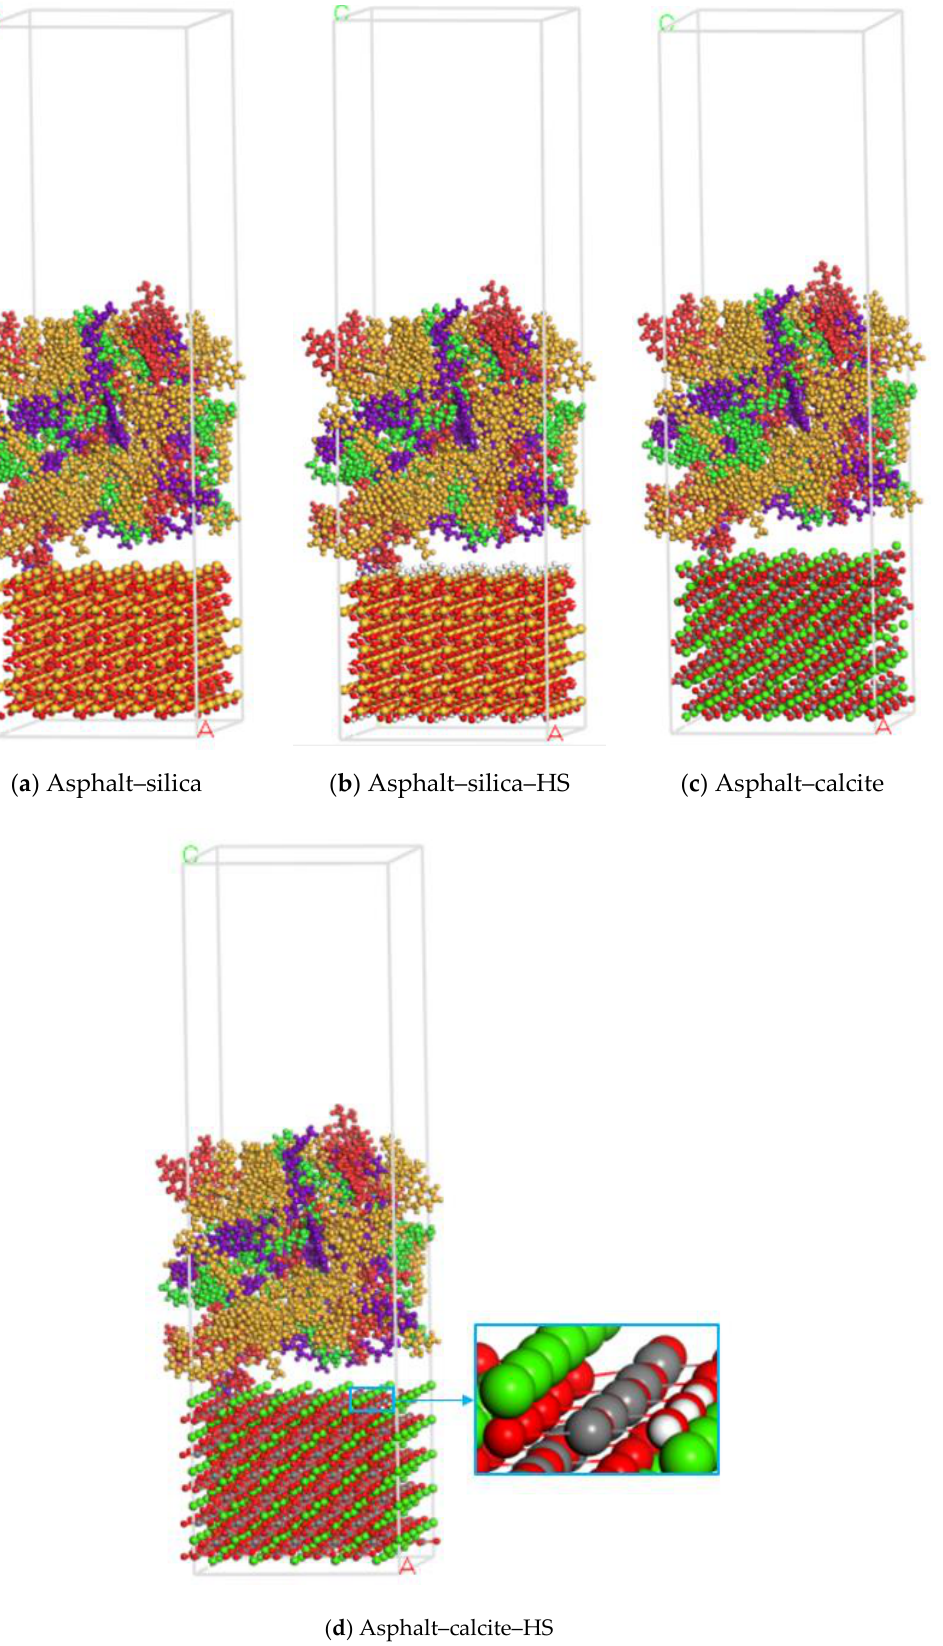
Figure 4. Asphalt–aggregate interface model.